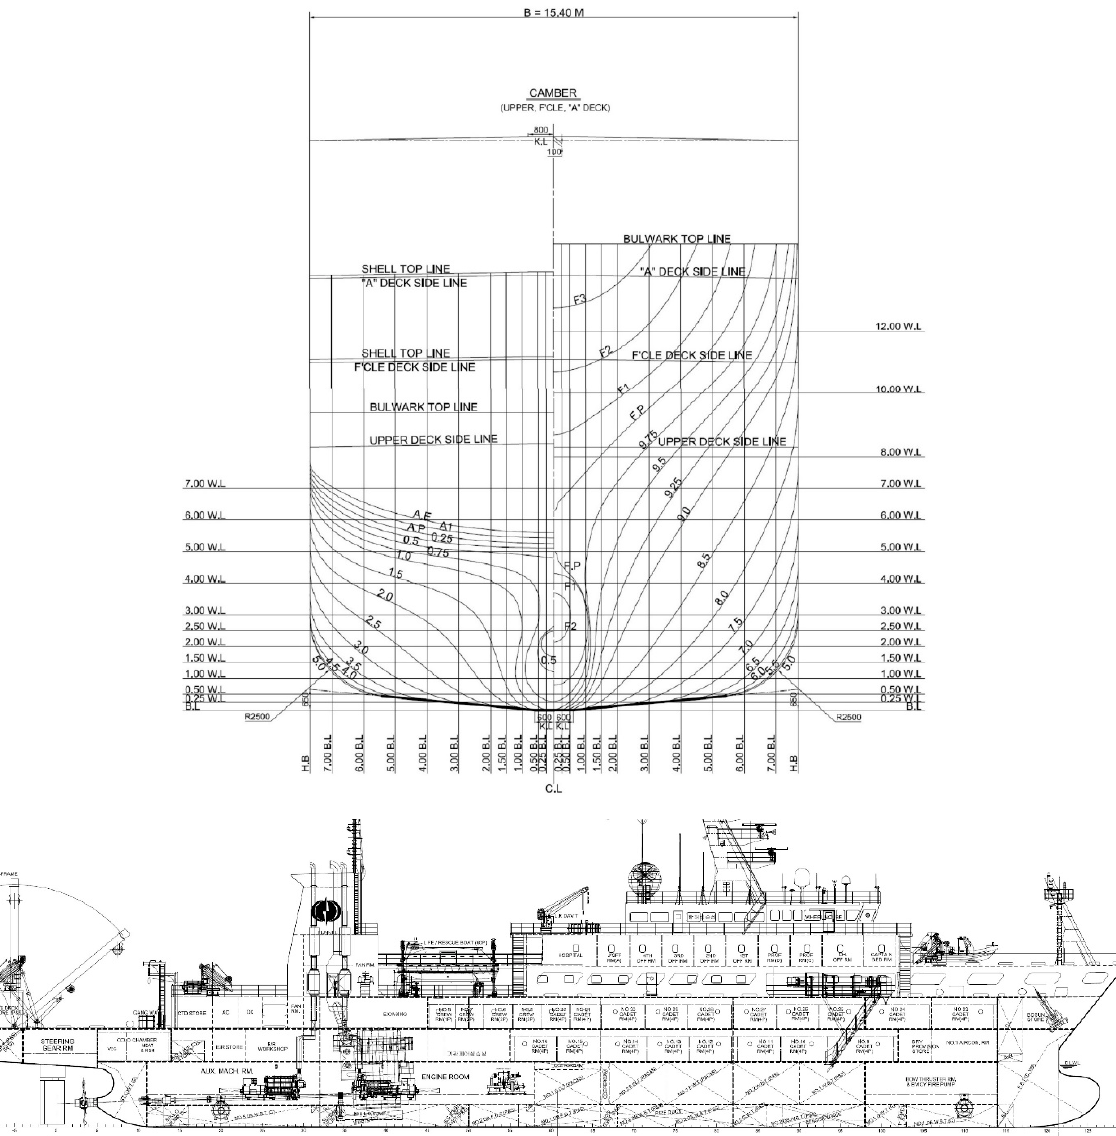
Figure 6. Body plan and general arrangement of the target trawler.